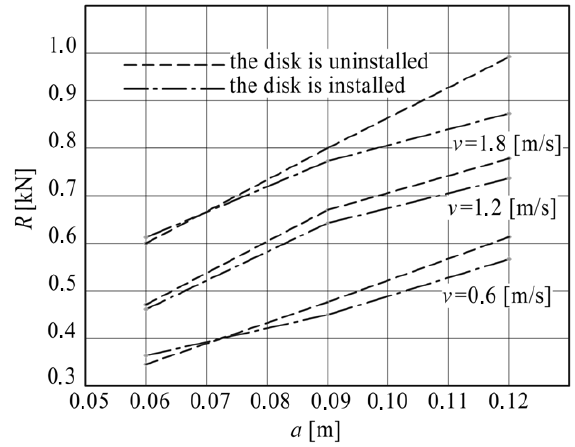
Figure 16. The dependence of the tractive resistance of the sowing section (with and without the installed slotting disk) on the working speed and tilling depth (with a vertical load P 5 =